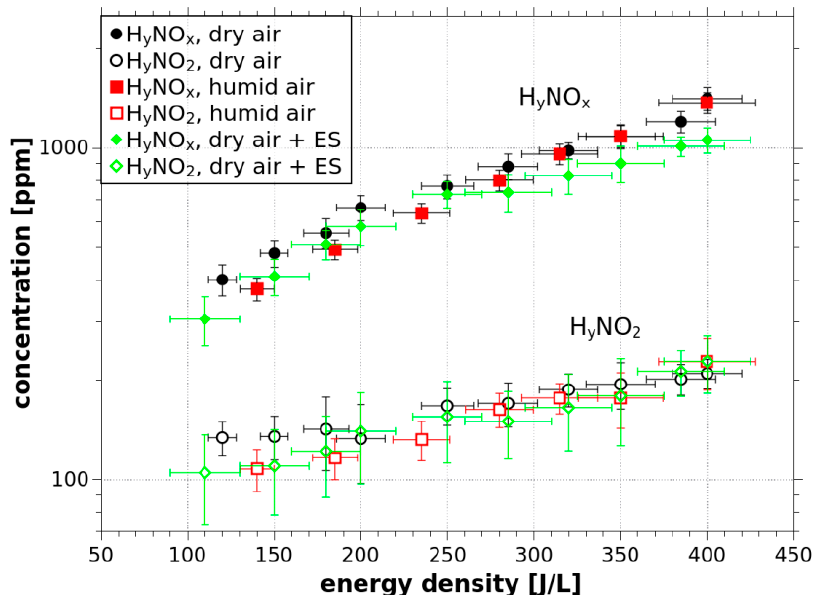
Figure 10. H y NO 2 (HNO 2 +NO 2 ) and H y NO x (HNO 2 +NO 2 +NO) concentrations as functions of the TS input energy density, comparison of dry air, humid air, and dry air + ES, measured by UV-Vis absorption technique, short cell, 1SS.